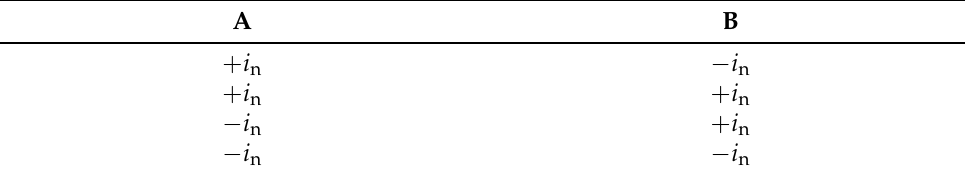
Table 1. Full-step control table.